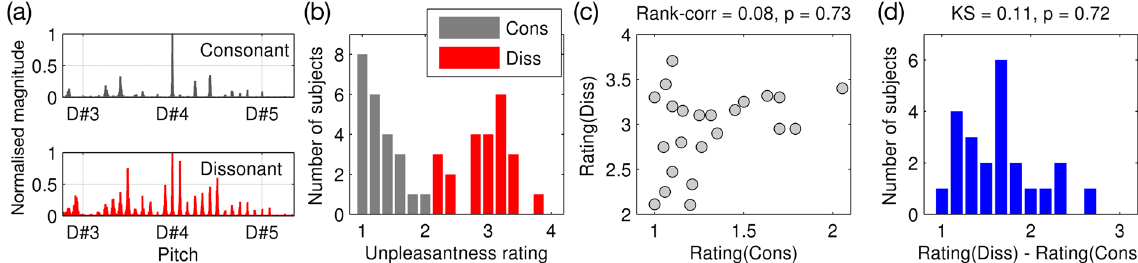
Figure 1. Consonant and dissonant musical excerpts and the subjective rating of unpleasantness by participants. ( a ) Periodograms of an example excerpt (from “Prelude and Fugue No. 3” by J. S. Bach) in its original (i.e., consonant; grey) and dissonant (red) versions. Normalised magnitude is plotted over a log-linear scale of pitch (c.f., D#4 = 311.13 Hz). ( b ) A histogram of subjective ratings of consonant (grey) and dissonant (red) music. ( c ) A scatterplot of ratings of dissonant music over ratings of consonant music. Spearman rank correlation test statistics are noted at the top of the scatterplot. ( d ) A histogram of increased unpleasantness rating due to dissonance (i.e., dissonant – consonant). The Kolmogorov-Smirnov test statistics are shown at the top of the histogram. Abbreviations: cons, consonant; diss,